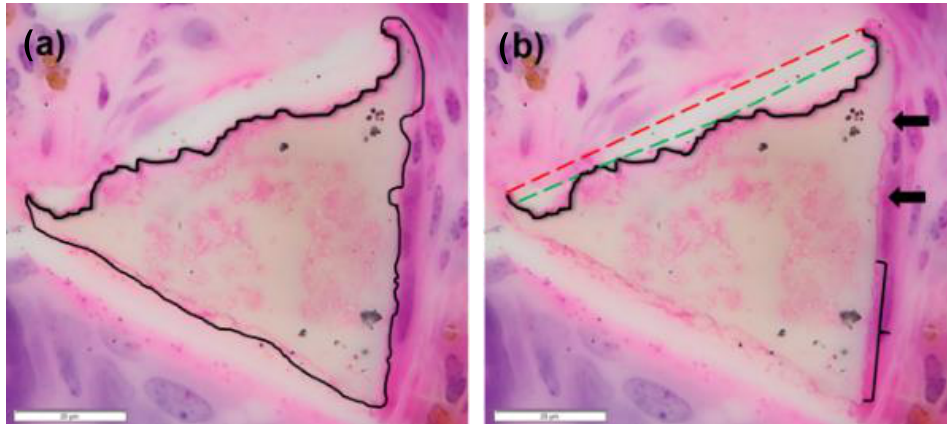
Figure 6. Occasional struts presented with larger degradation regions with compounded scalloping along the edges ( a ). These struts lacked a reference section on the edge. Maximal and minimal degradation lines were drafted for these cases ( b ), where the green dashed line represents the lowest possible degradation measured from strut edge assumptions, and the red dashed line represents the highest possible degradation measured. For reference, typical degradation regions are identified (black arrows) and a diminished scalloped degradation region is outlined (bracket). Tissues were stained with hematoxylin and eosin (H&E) (20 μm) .